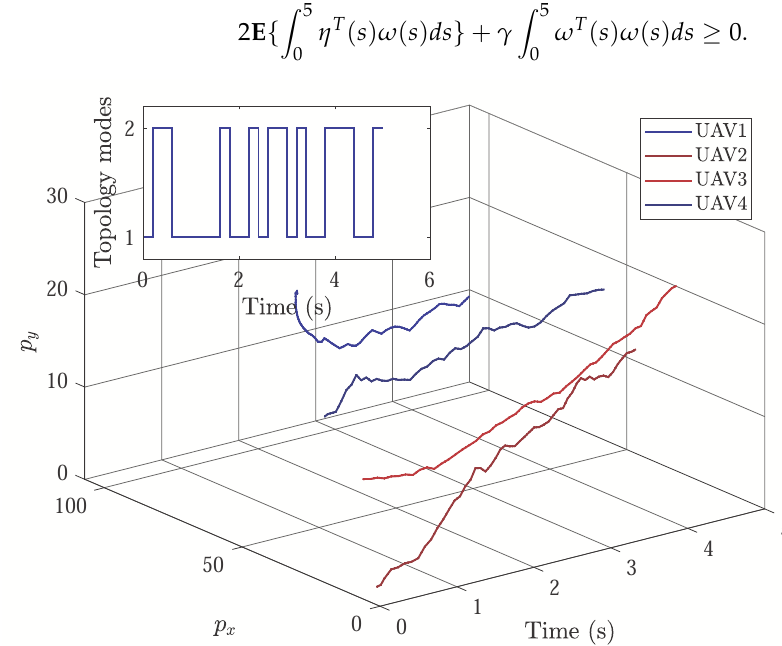
Figure 2. Formation state trajectories of UAVs.